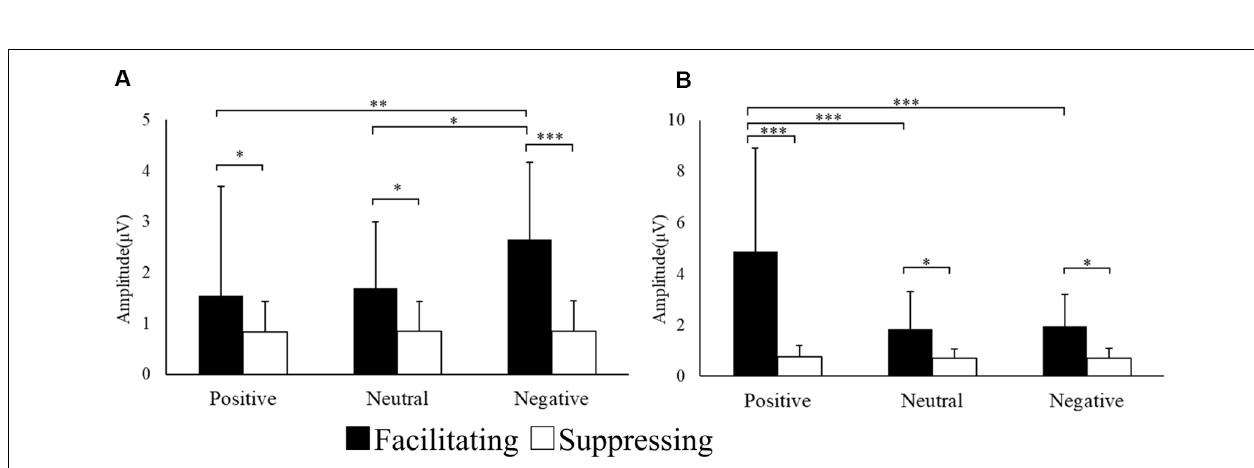
FIGURE 2 | Mean subjective rating scores for valence (A) , arousal (B) , and facial expression strength (C) . ∗ p < 0.05, ∗∗ p < 0.01 and ∗∗∗ p < 0.001.